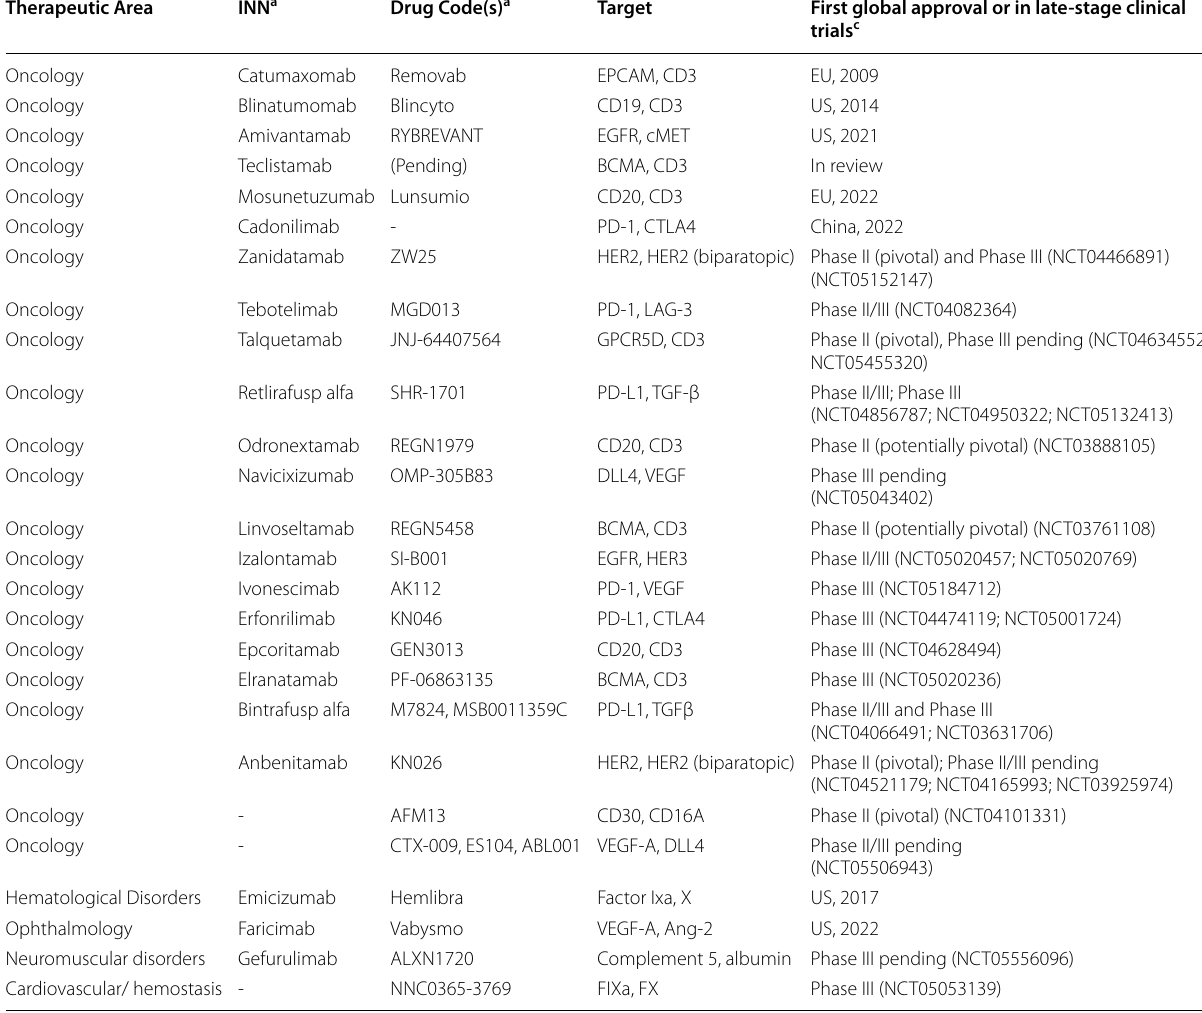
Table 3 BsAbs first approved or in late-stage clinical trials b